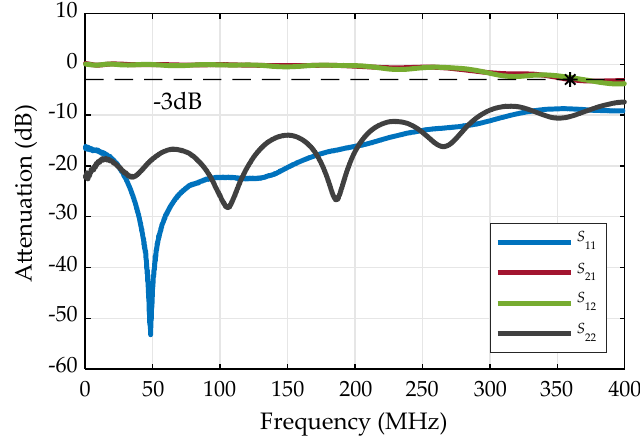
Figure 6. S-parameters of the configuration shown in Figure 5, for the frequency range corresponding to the rating of the used